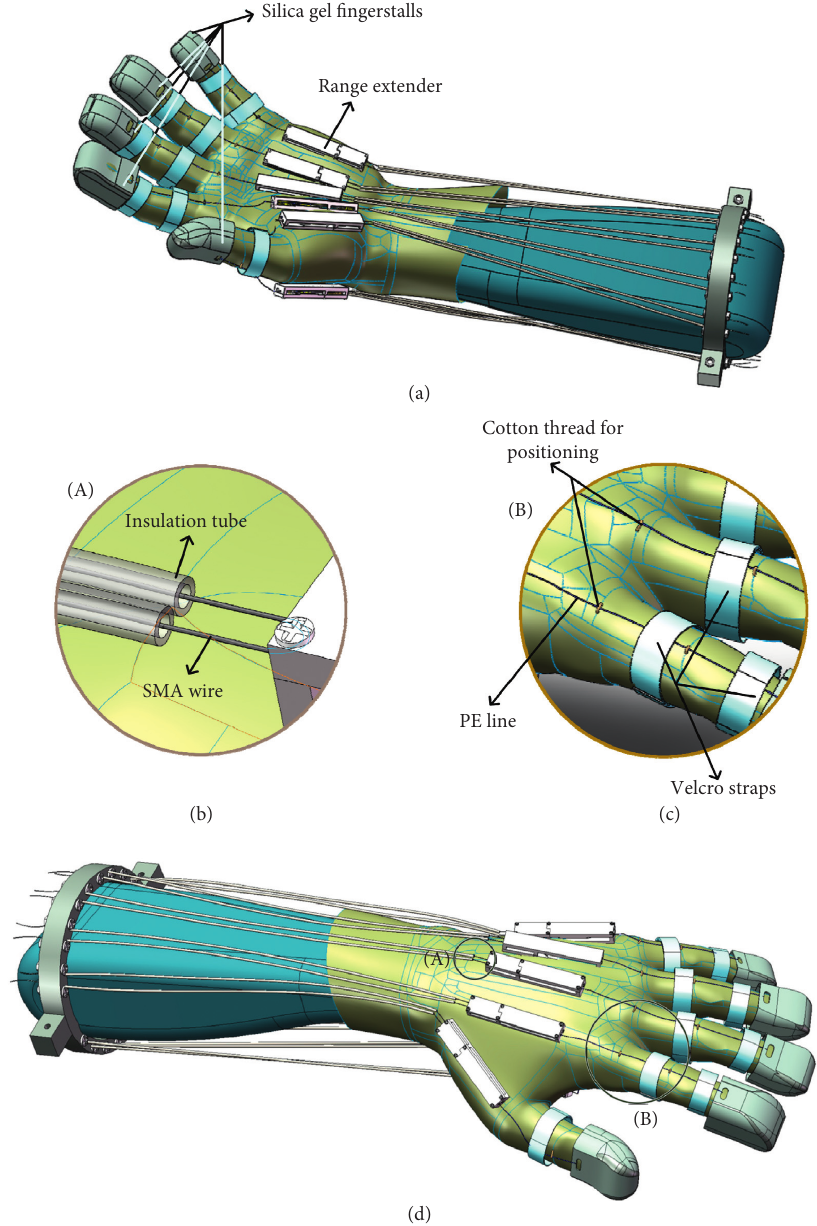
Figure 5: Conceptual design of the HMD.